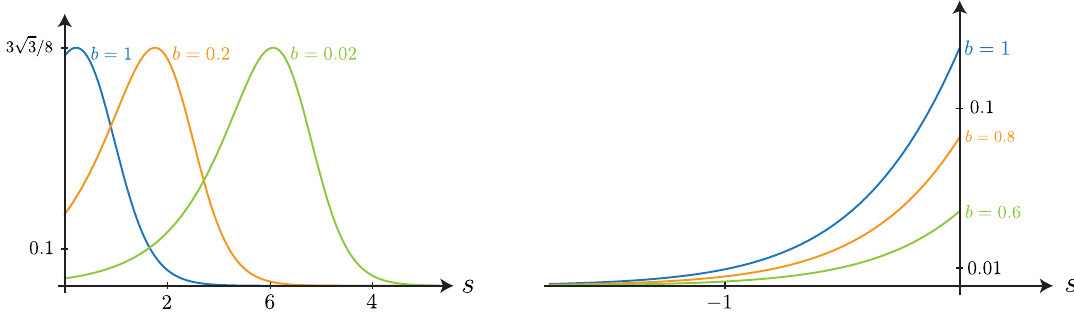
Figure 6 . Plot of the two kernels in the integral in (2.35) for several values of b . The left (right) diagram corresponds to the integral with positive (negative) s